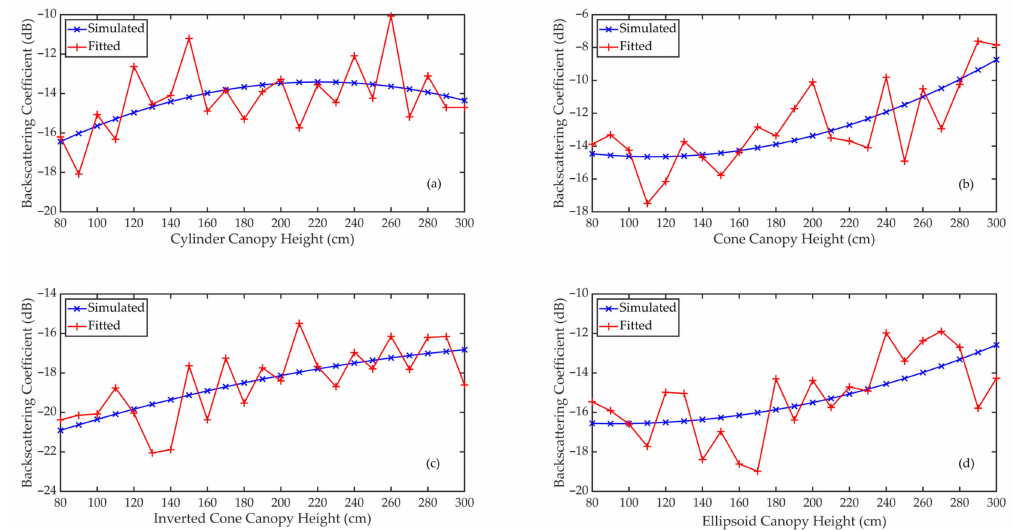
Figure 17. The simulated and fitted backscattering coefficients of vegetation canopies when using canopy A’s parameters as inputs at different canopy heights.